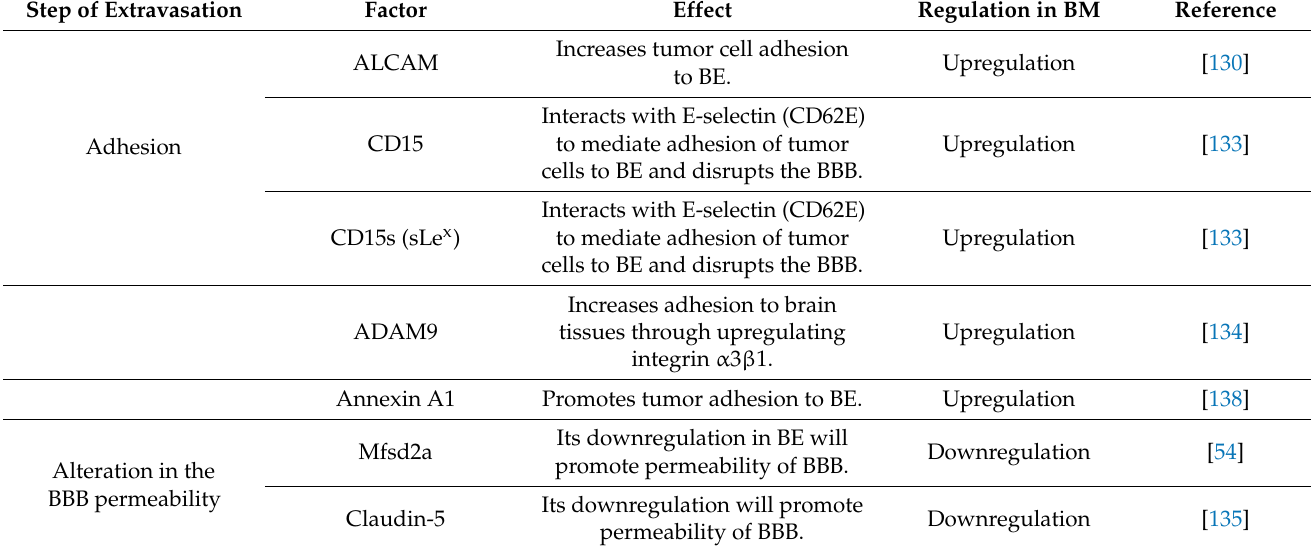
permeability of